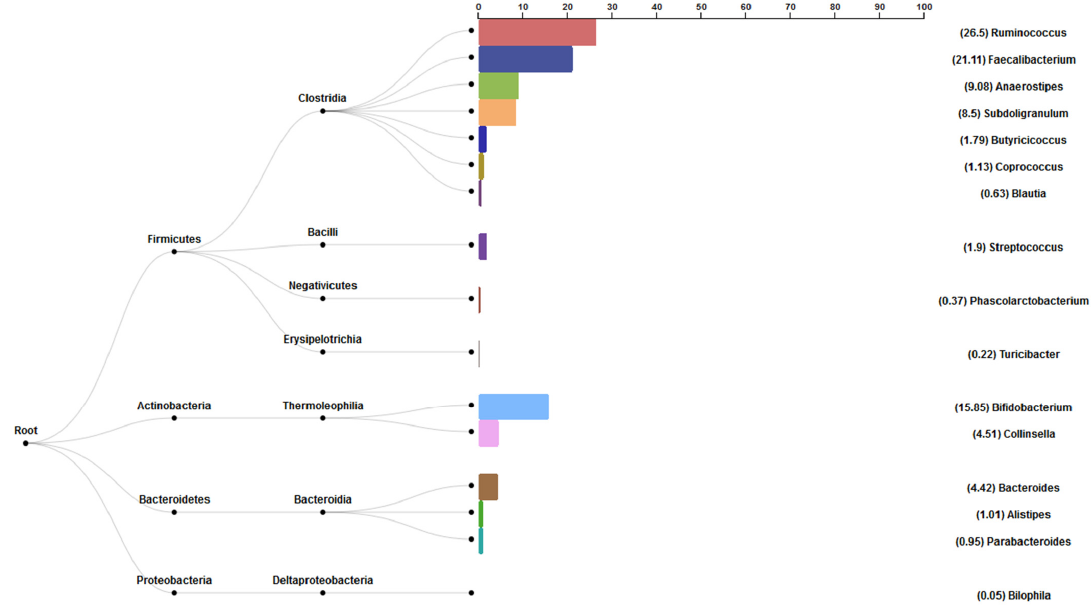
Figure 6. Bacterial abundance in the non-resistant group.